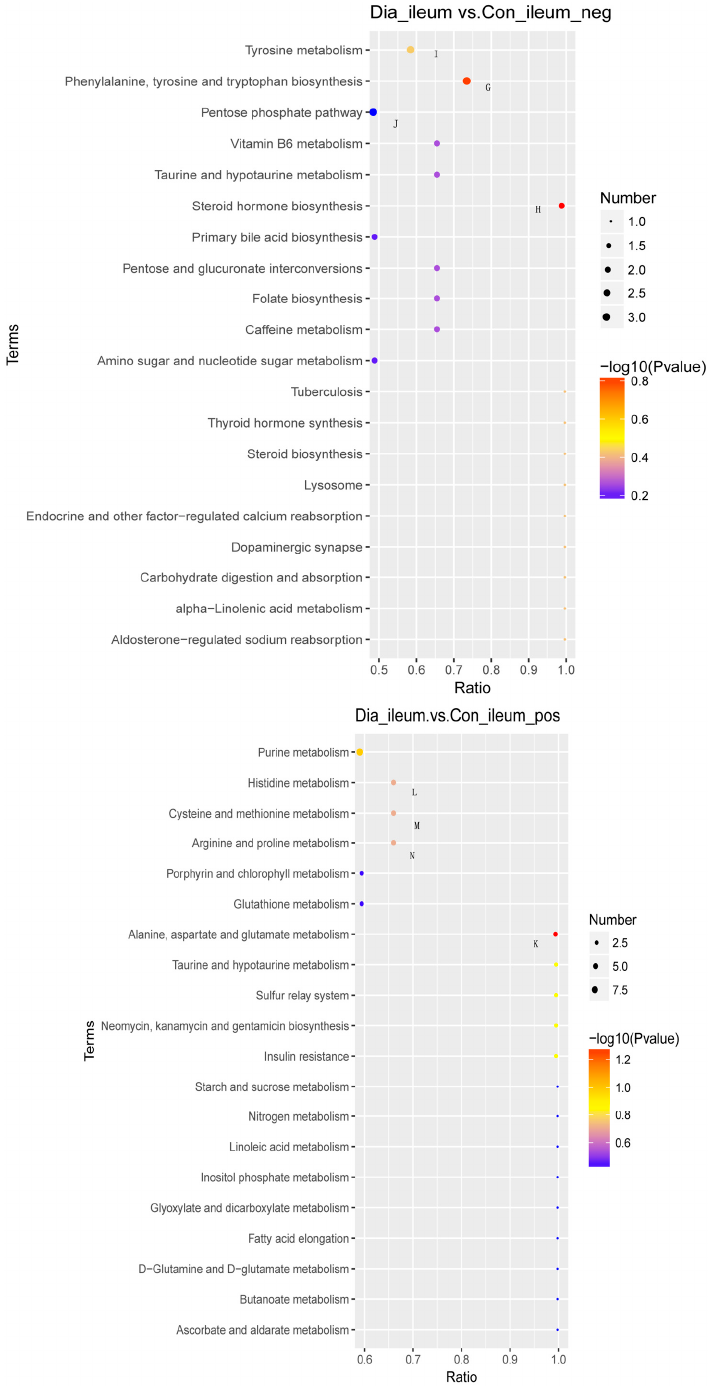
Figure 5. Bubble diagram for KEGG enrichment analysis of differential metabolites in positive and negative modes in jejunum, ileum, and cecum samples from Hyplus rabbits. A. Inositol phosphate metabolism; B. pentose phosphate pathway; C. galactose metabolism; D. cysteine and methionine metabolism; E. ubiquinone and other terpenoid − quinone biosynthesis; F. AMPK signaling pathway; G. phenylalanine, tyrosine, and tryptophan biosynthesis; H. steroid hormone biosynthesis; I. tyrosine metabolism; J. pentose phosphate pathway; K. alanine, aspartate, and glutamate metabolism; L. histidine metabolism; M. cysteine and methionine metabolism; N. arginine and proline